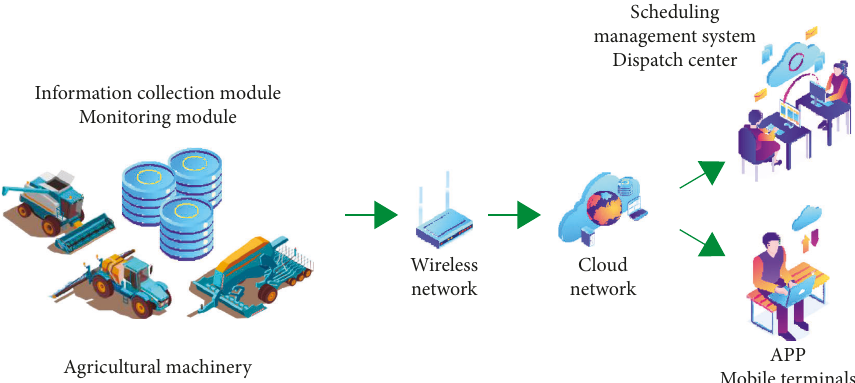
Figure 1: A large-scale agricultural machinery regional dispatch management system based on the internet of